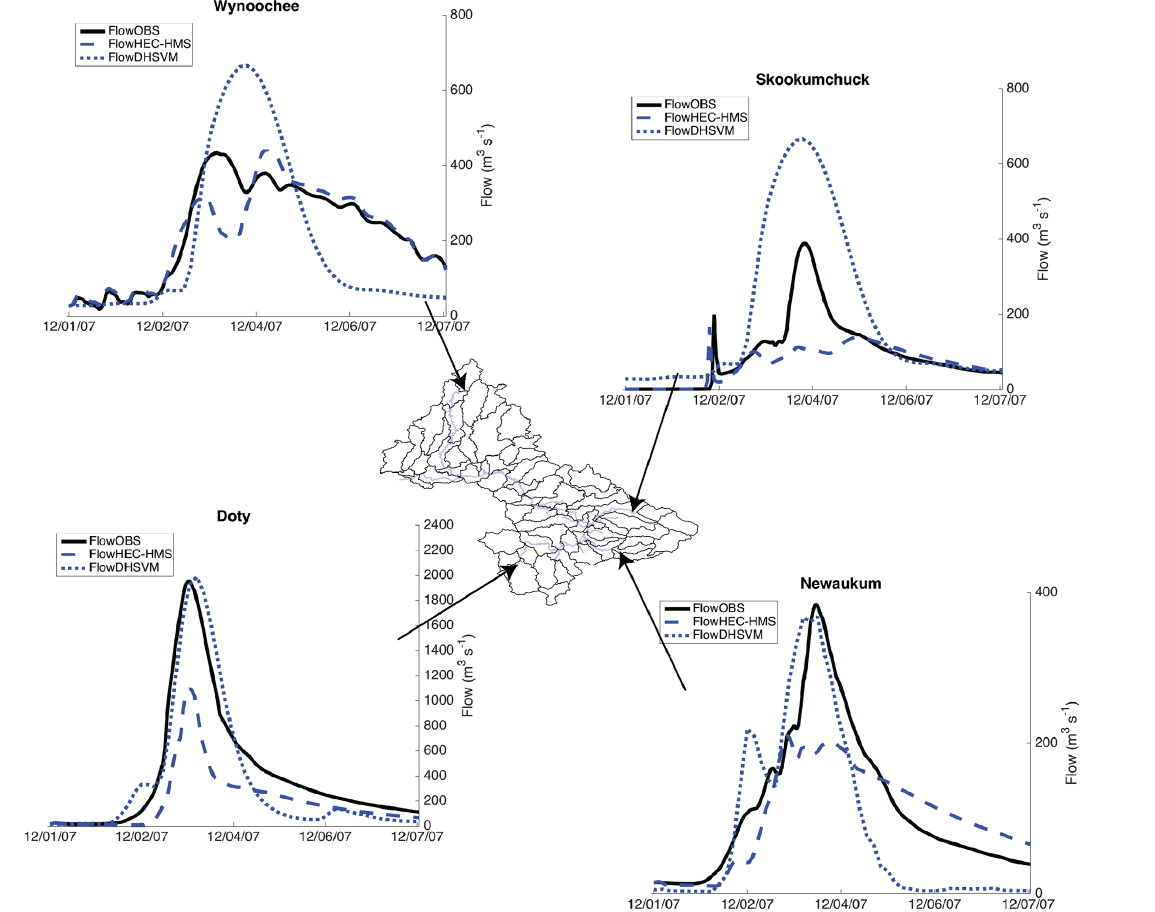
Figure 5. USGS observed (solid black), HEC-HMS simulated control (dashed blue) and DHSVM simulated (dotted blue) discharge for four representative sub-basins within the